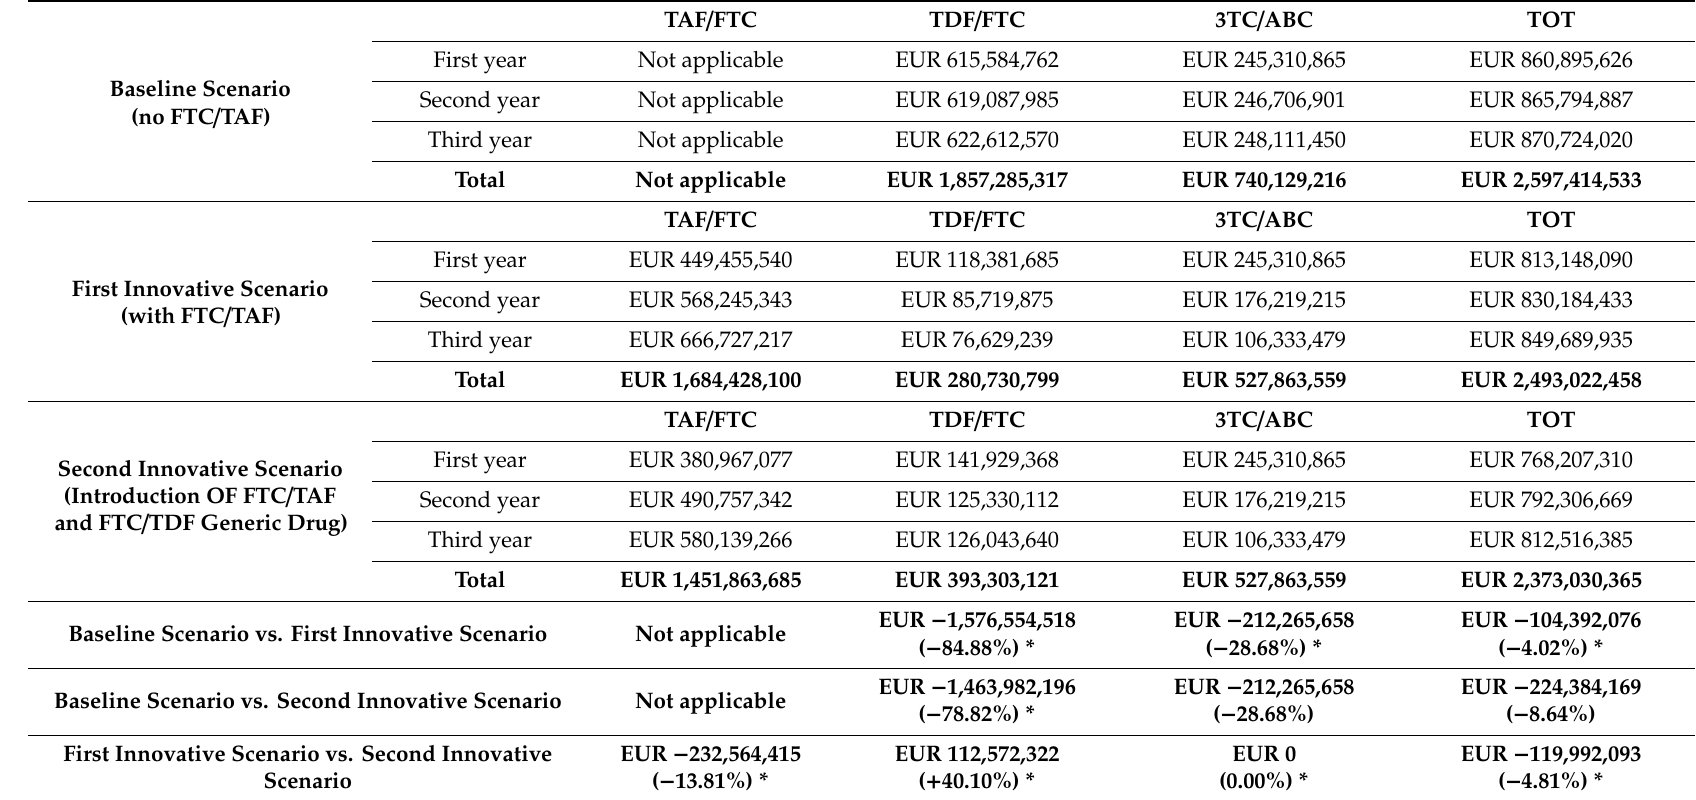
Table 7. Budget impact analysis. Source: data gathered by